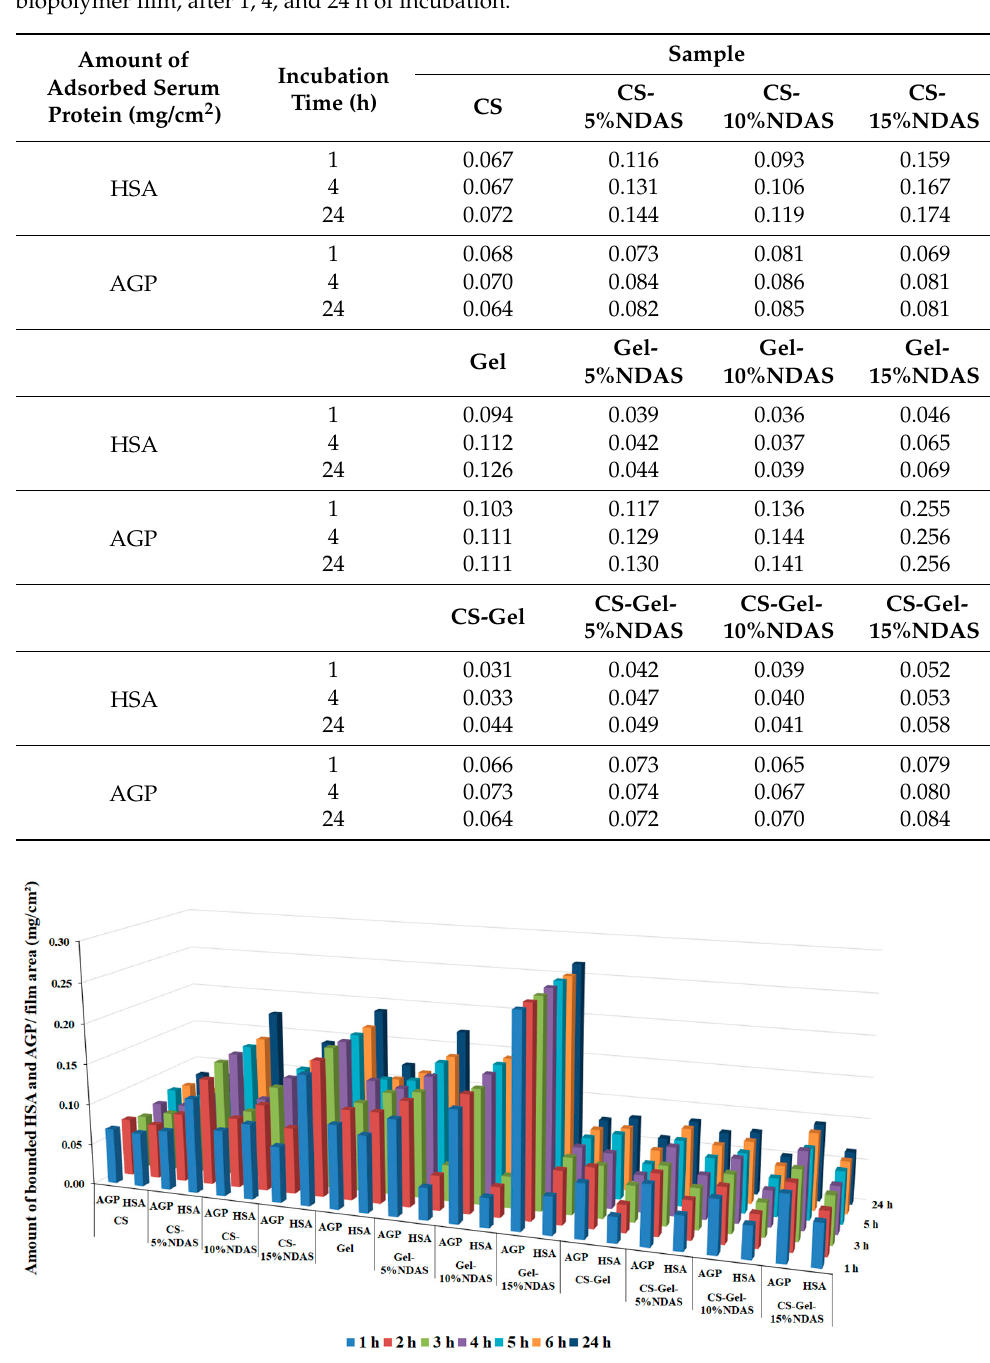
Figure 9. Amount of bound serum proteins AGP and HSA at the surface of obtained biopolymer films.